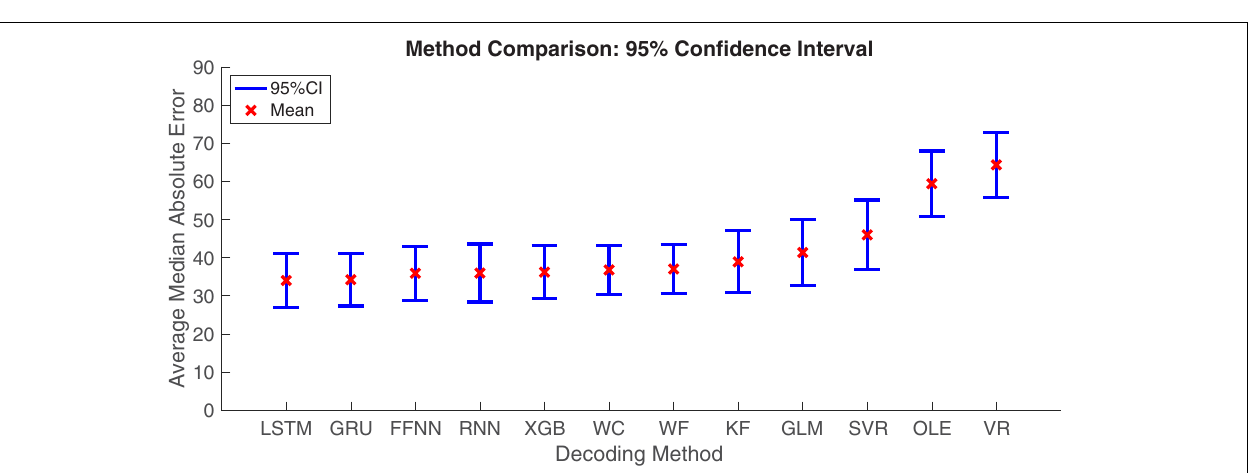
possible that some of the variability in decoding accuracy across brain regions may be an indirect result of HD cell density. We directly assess the potential influence of the number of